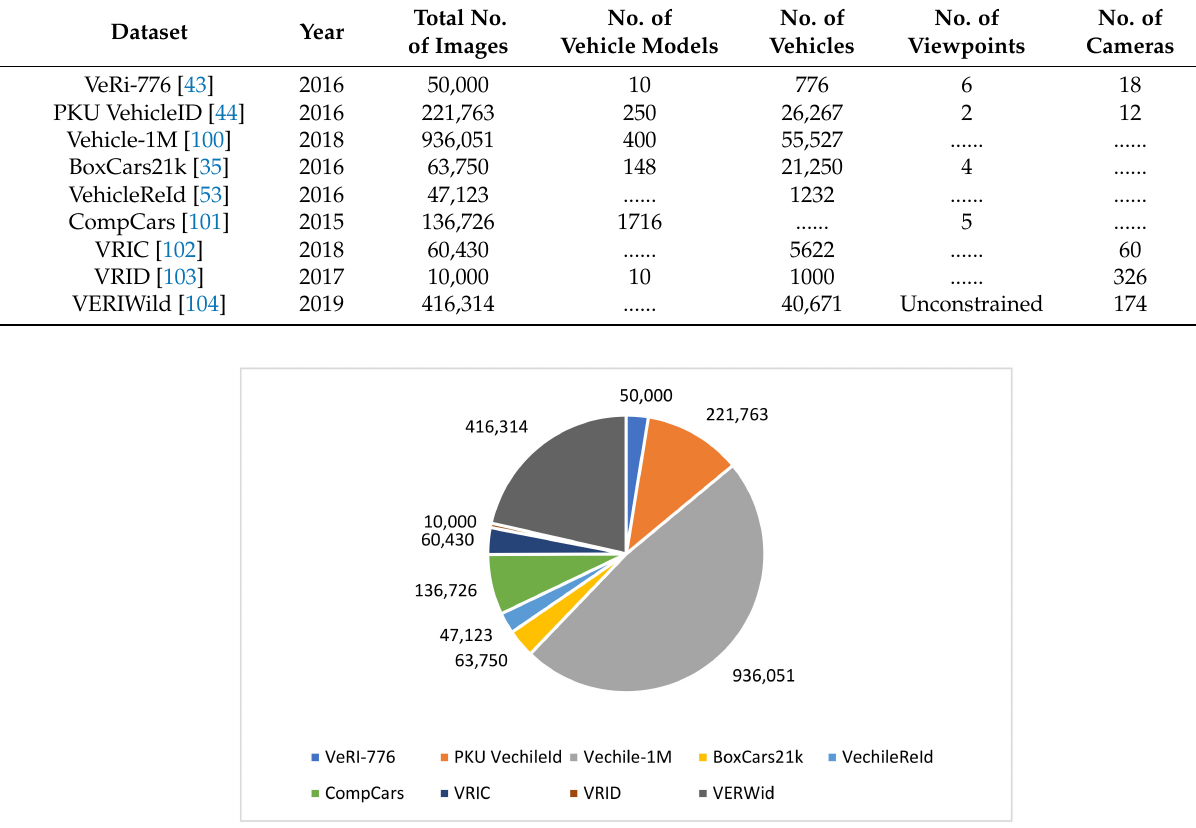
Figure 18. Depicts the number of total images per vehicle re-id dataset.